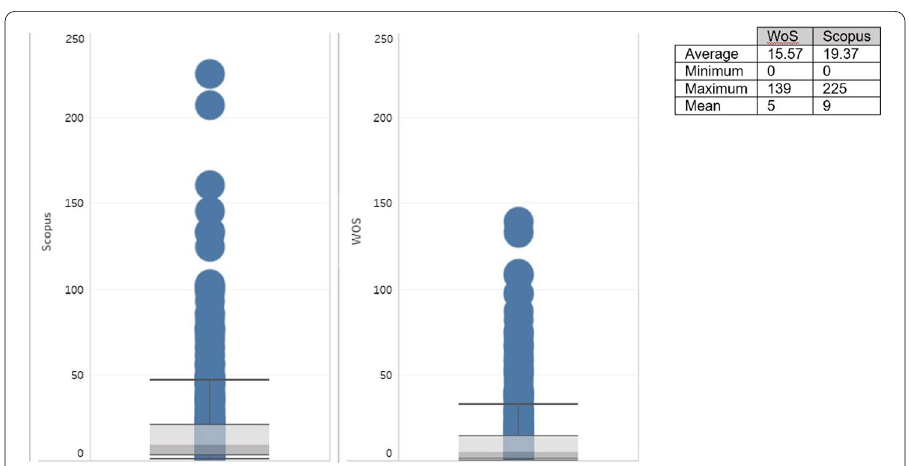
Fig. 3 Comparison of citations. Source : Own